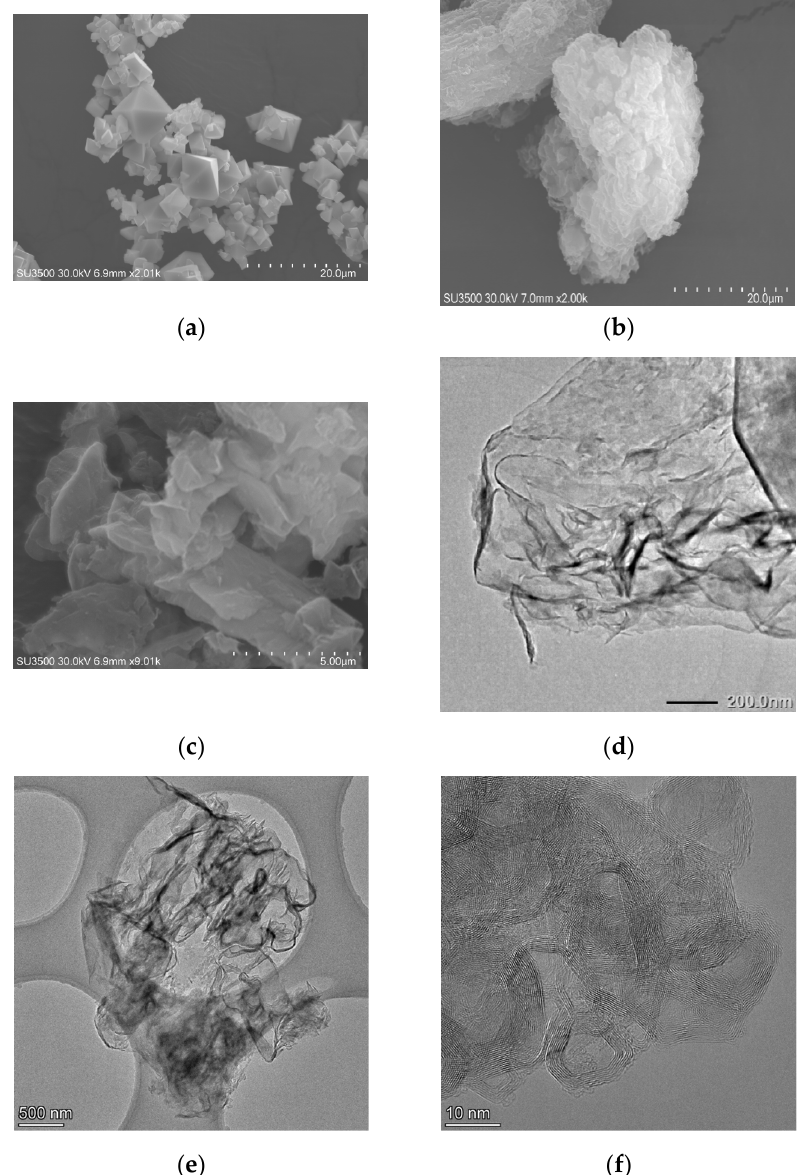
Figure 2. SEM images of ( a ) Co 3 O 4 , ( b ) 0.5% Co 3 O 4 /g-C 3 N 4 , and ( c ) Pt/0.5% Co 3 O 4 /g-C 3 N 4 . The TEM image of ( d ) 0.5% Co 3 O 4 /g-C 3 N 4 and ( e , f ) Pt/0.5% Co 3 O 4 /g-C 3 N 4 .